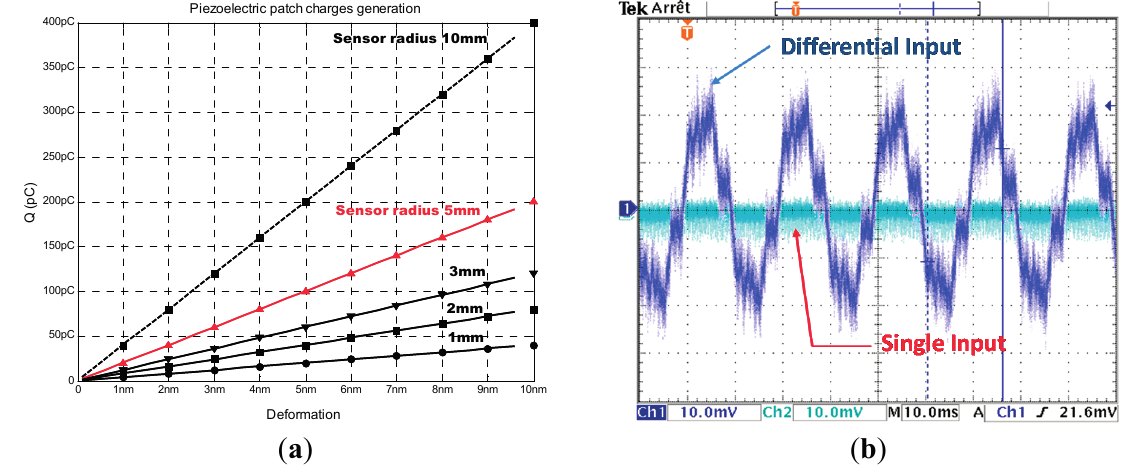
Figure 8. Piezoelectric charge conversion to exploitable voltage. ( a ) Piezoelectric charges generation for differents radial deformations and differents sensor sizes; ( b ) Noise performance of a differential input charge amplifier versus a single input